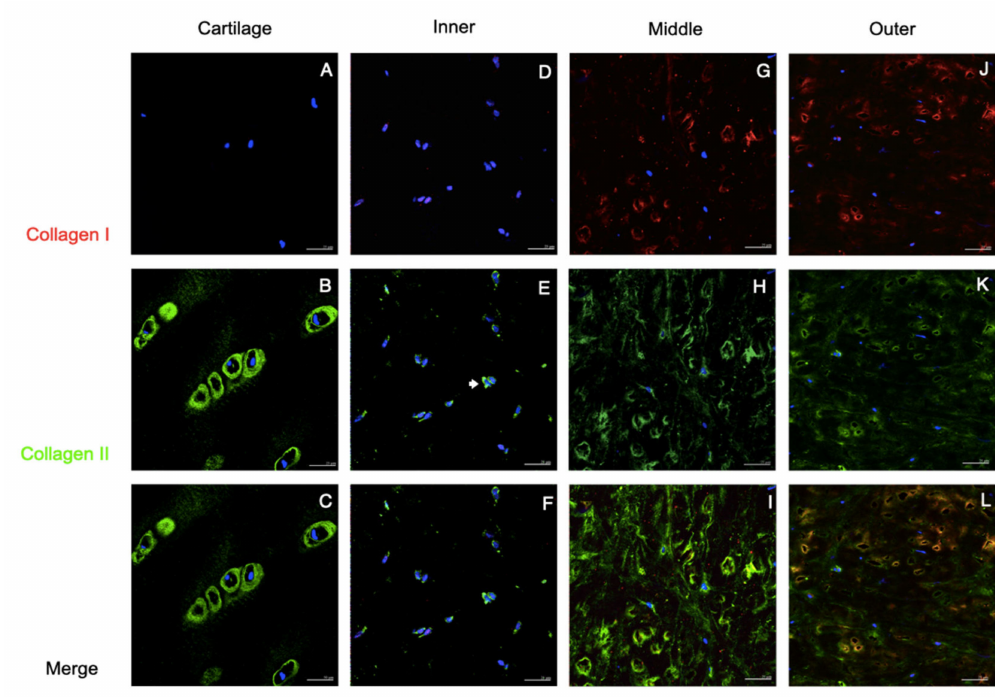
Figure 3. Collagen I and collagen II staining of the native tissues. Immunofluorescent localized type I and II collagen in human cartilage and meniscus. Positive staining of Col II in the pericellular